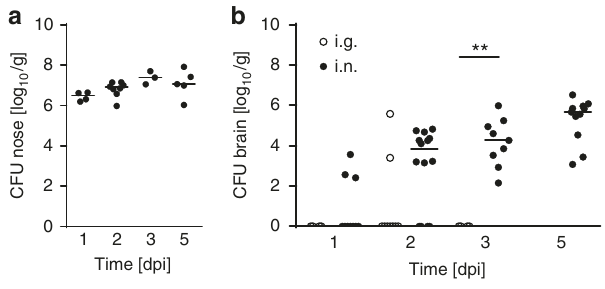
Fig. 1 Spread of Lm to CNS tissue after nasal administration. Bacterial counts in nasopharyngeal mucosal tissue ( a ) and total brain tissue ( b ) at 1, 2, 3 and 5 days post infection (dpi). One-day-old mice were infected with either 1 × 10 7 CFU intragastrically ( ○ , i.g.) or 1 × 10 4 CFU intranasally ( ● , i. n.). Each dot de fi nes an individual mouse. Nose: n = 4 (1 dpi), n = 8 (2 dpi), n = 3 (3 dpi), n = 5 (5 dpi); brain i.n.: n = 10 (1 dpi), n = 14 (2 dpi), n = 9 (3 dpi), n = 10 (5 dpi); brain i.g.: n = 4 (1 dpi), n = 9 (2 dpi), n = 4 (3 dpi); median; unpaired, two-tailed Mann – Whitney test; ** p <